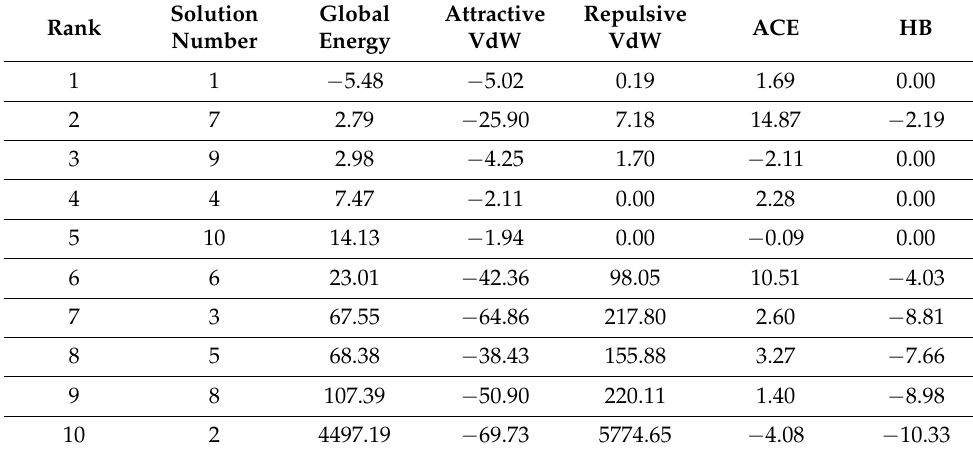
Table 5. Top 10 refined complexes of vaccine and MHC-I molecule. vdW (van der Waals energy), ACE (atomic contact energy), and HB (hydrogen bond energy).